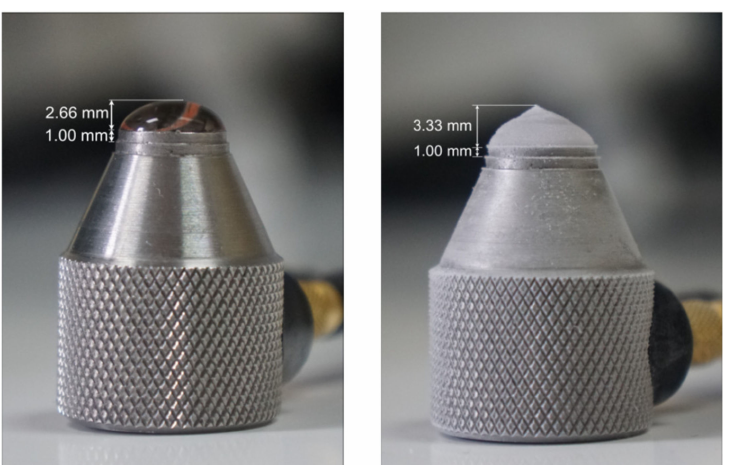
Figure 4. Optical determination of drop height from a liquid drop ( left ) and from a frozen drop ( right ). From these photographs, the well-known dimensions of the transducer element were used to estimate the drop dimensions in all the